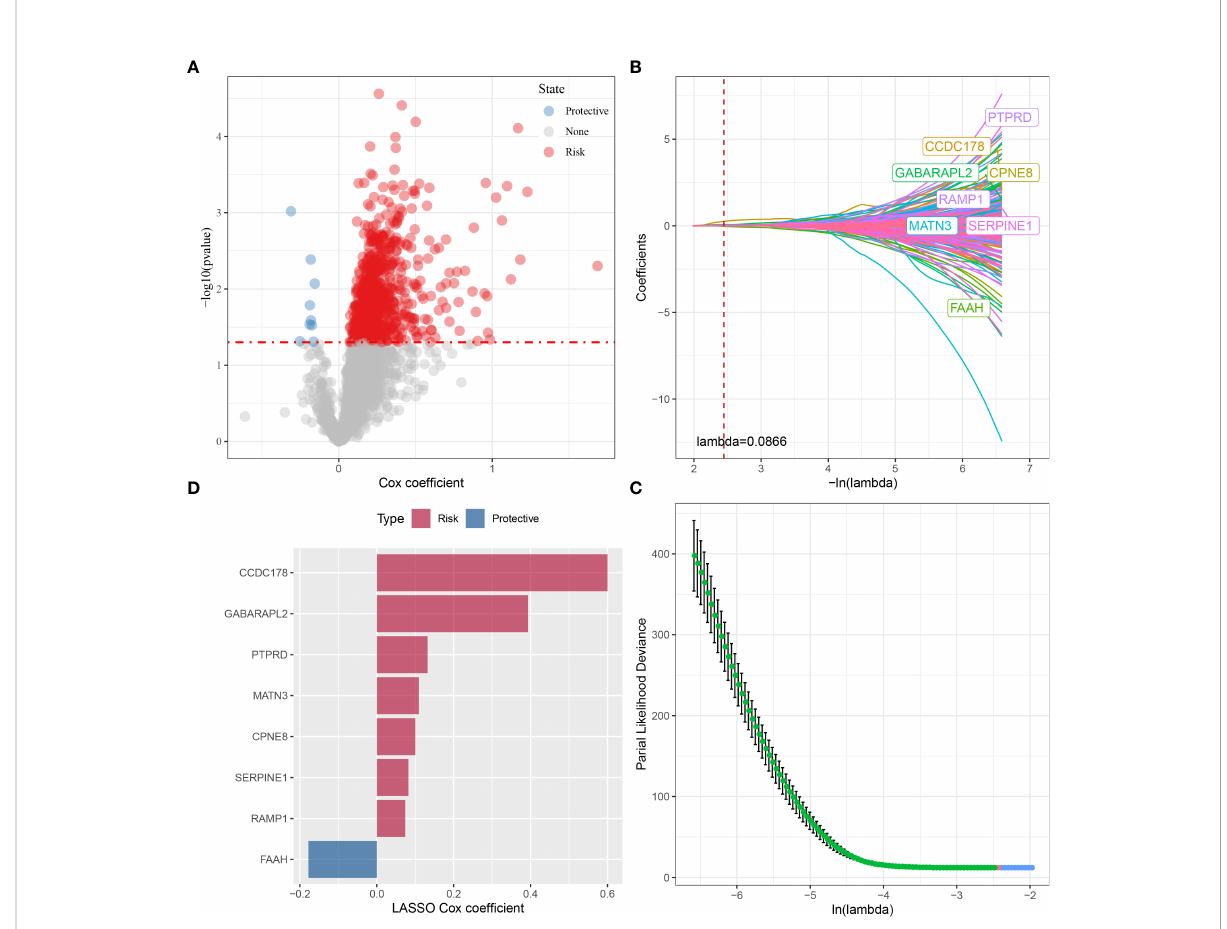
FIGURE 6 The identi fi cation of prognostic OSRGs for risk signature in the TCGA cohort. (A) The identi fi cation of prognostic OSRGs from the red module via univariate COX regression analysis. (B) The LASSO analysis was used to identify the prognostic variables and develop the predictive models. (C) Plots of the produced coef fi cient distributions for the logarithmic (lambda) series for parameter selection (lambda). (D) The LASSO Cox coef fi cients for each OSRGs in the risk